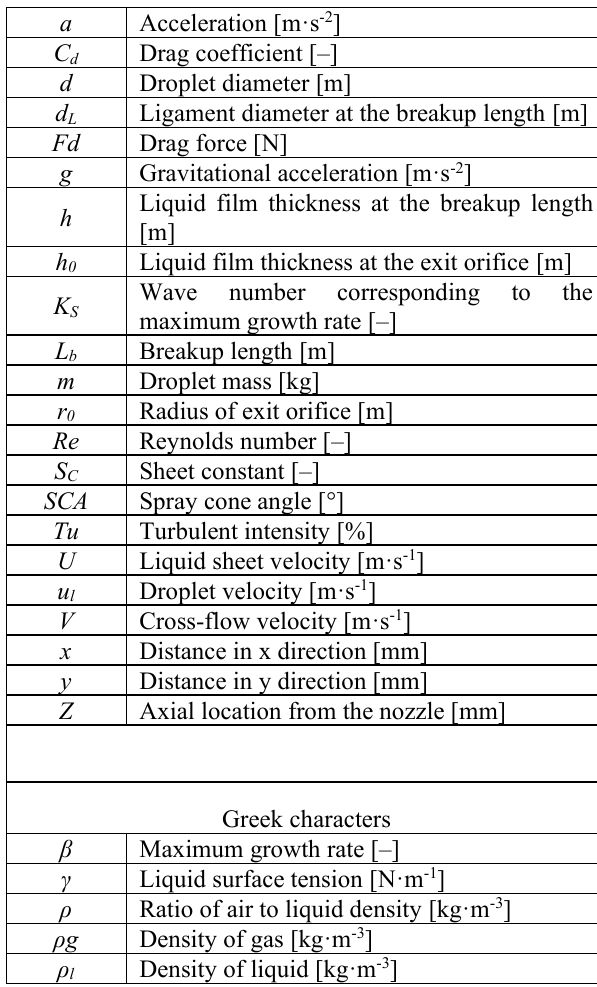
Fig. 14 Comparison of droplet trajectories predicted by LISA and high-speed visualization for 16 m/s is compared with experimentally obtained PDA data.